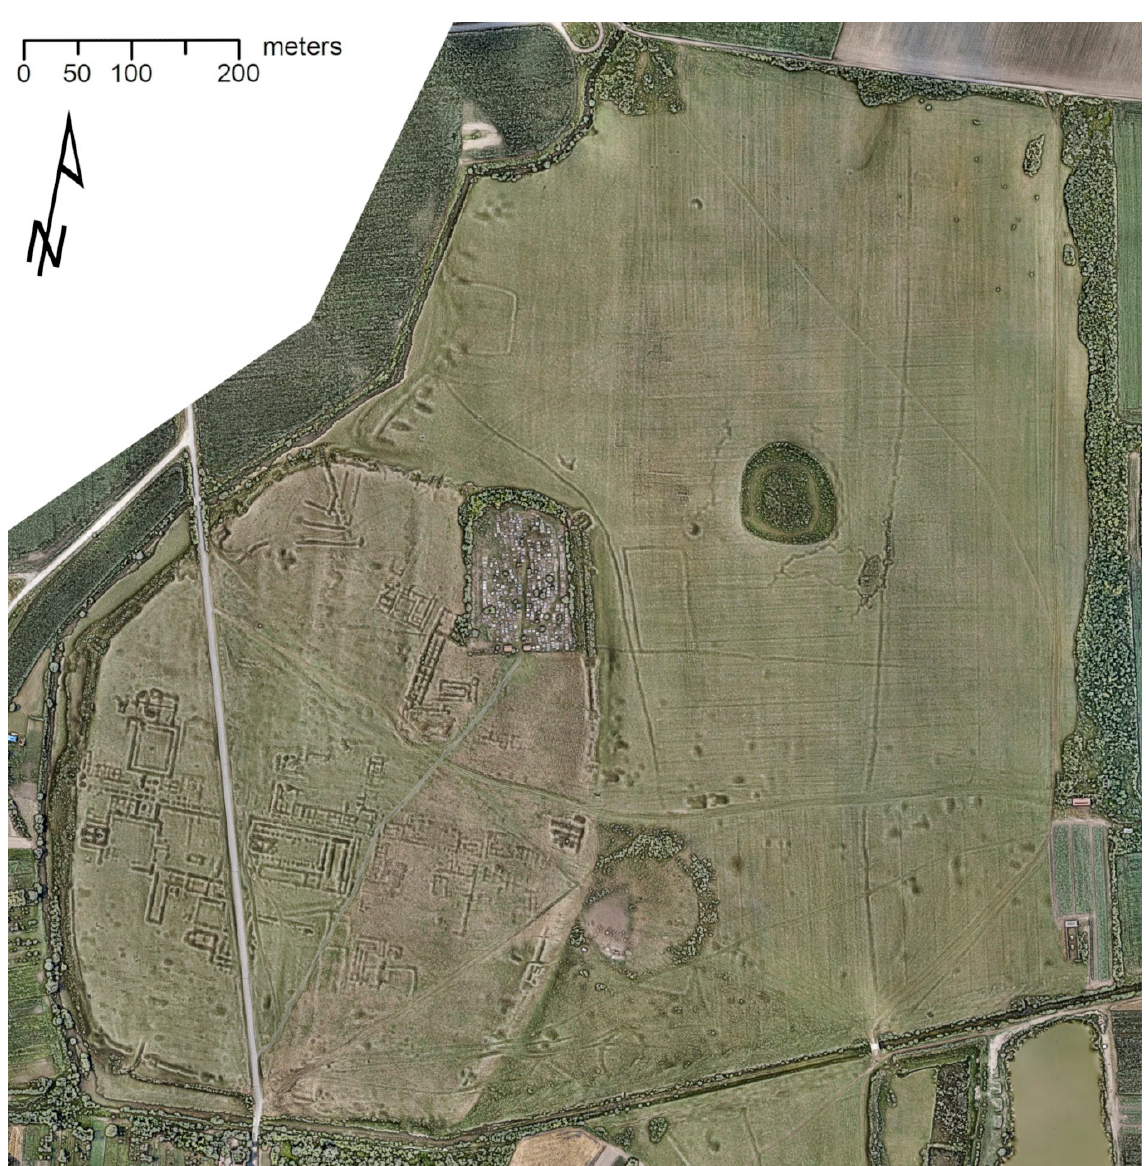
Figure 13. Visualization of present-day Bassianae using a “hard light” image fusion of the UAS imagery-based orthophoto with a relief rendering, the latter being the result of a “hard light” image fusion between a multidirectional hillshade (35° solar elevation, vertical exaggeration factor of 3) and local dominance visualization ((min, max) kernel radii = (20, 40) raster cells) of the DSM. Opacity levels and global contrast levels were tuned for each intermediary fused result to achieve optimum clarity of the topographic features.